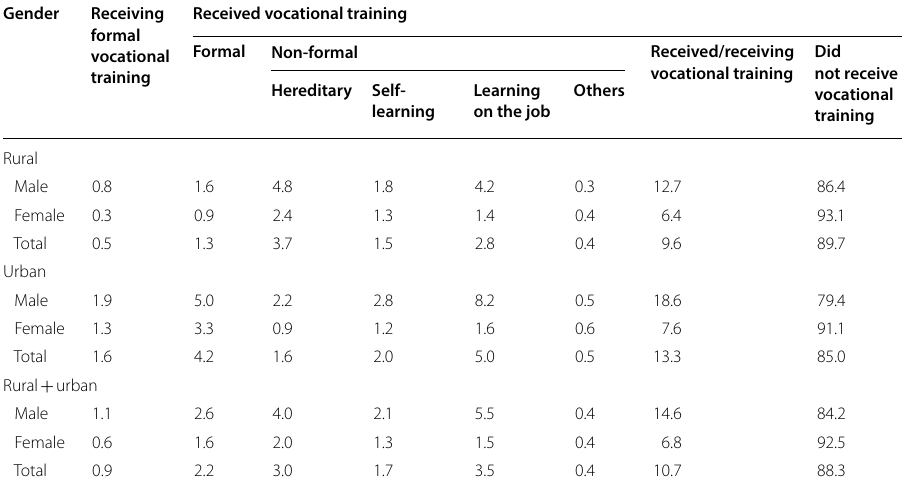
Table 3 Population who received/are receiving vocational training per 100 persons (15– 59 years of age)—detailed description. Source: NSSO (2015) Gender